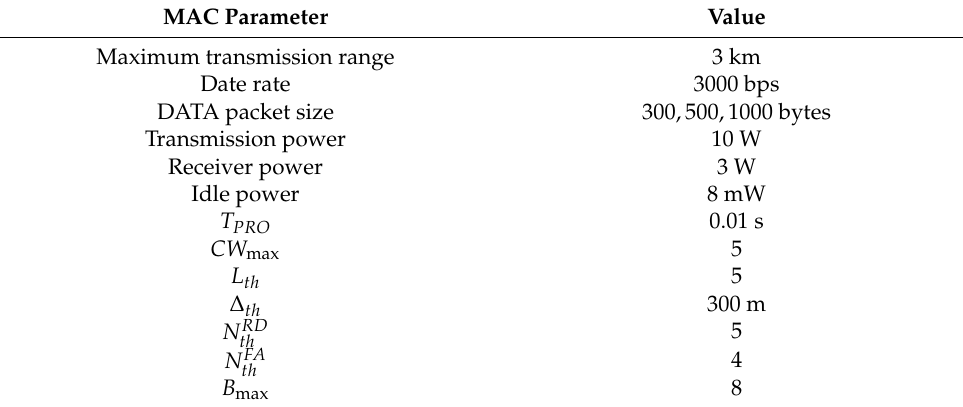
Table 2. Simulation parameter